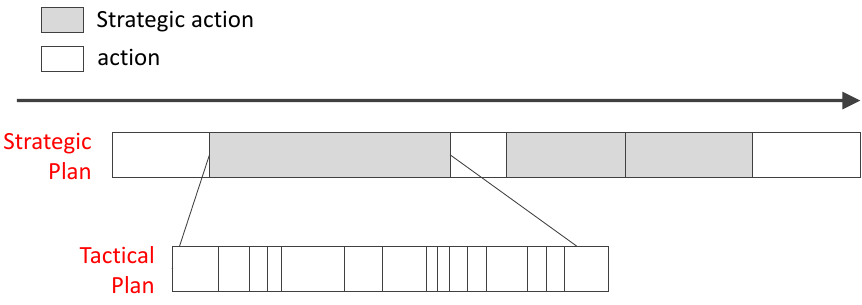
Figure 5. Strategic plan and tactical plan: The strategic plan consists of strategic action and action. The tactical plan is generated when a strategic action is performed and is